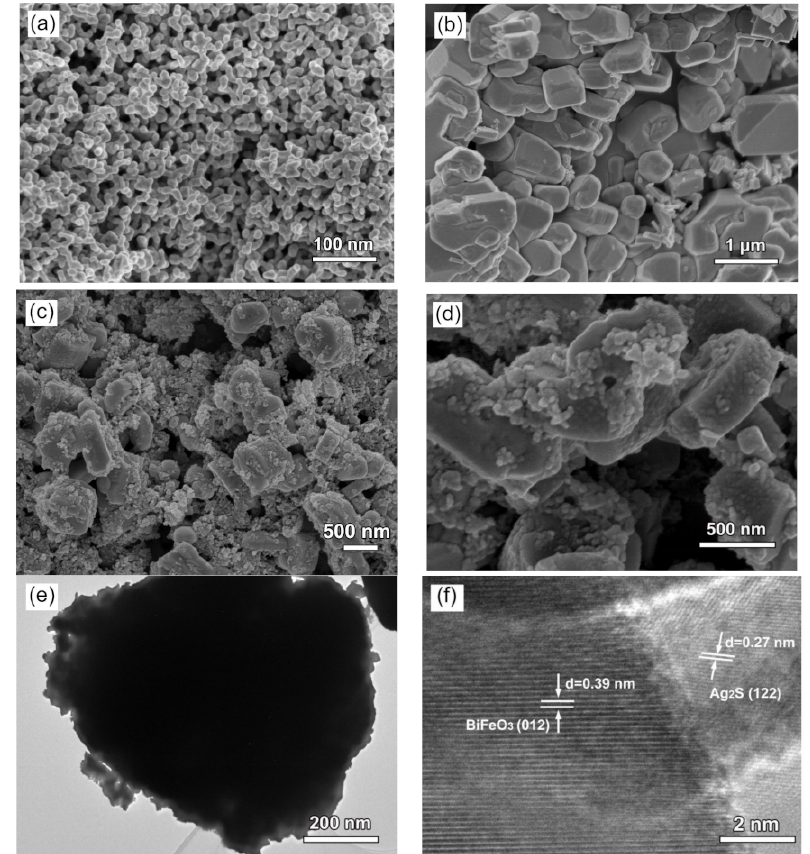
Figure 4. ( a – d ) Scanning electron microscopy (SEM) images of Ag 2 S nanoparticles, BiFeO 3 particles and 15% Ag 2 S/BiFeO 3 , respectively. ( e ) and ( f ) Transmission electron microscopy (TEM) image and high-resolution (HR)TEM image of 15% Ag 2 S/BiFeO 3 ,